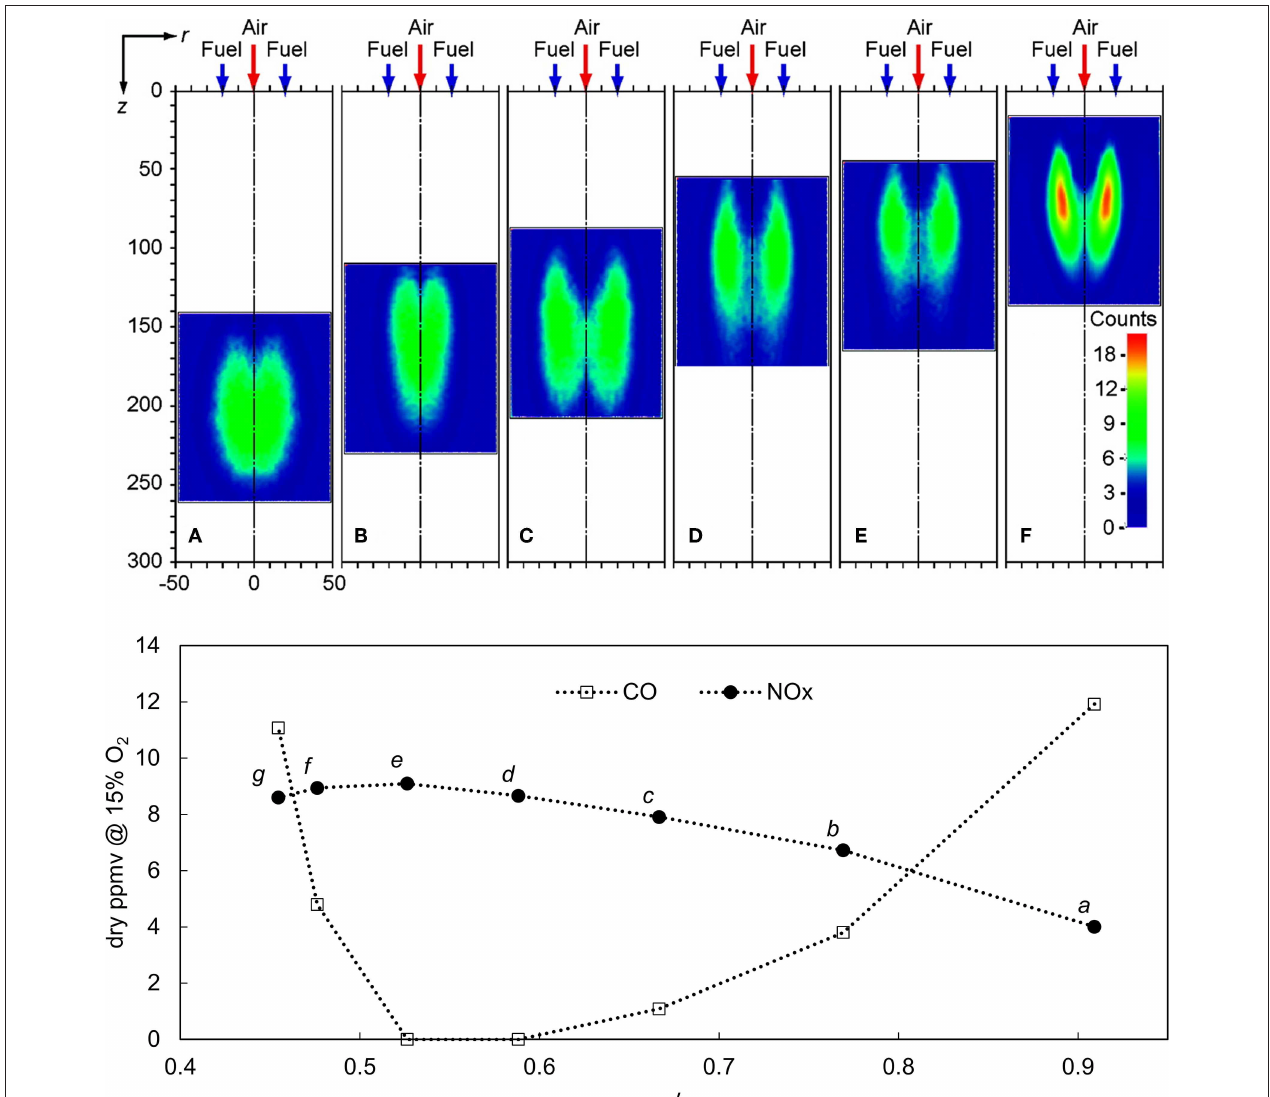
FIGURE 1 | Mean OH* images for diverse global equivalence ratio values. From left to right, φ ∼ = 0.91, 0.77, 0.67, 0.59, 0.53, 0.48 ( Above ). Emissions of NO x and CO in dry volumetric ppm adapted from Veríssimo et al. (2011) ( Below